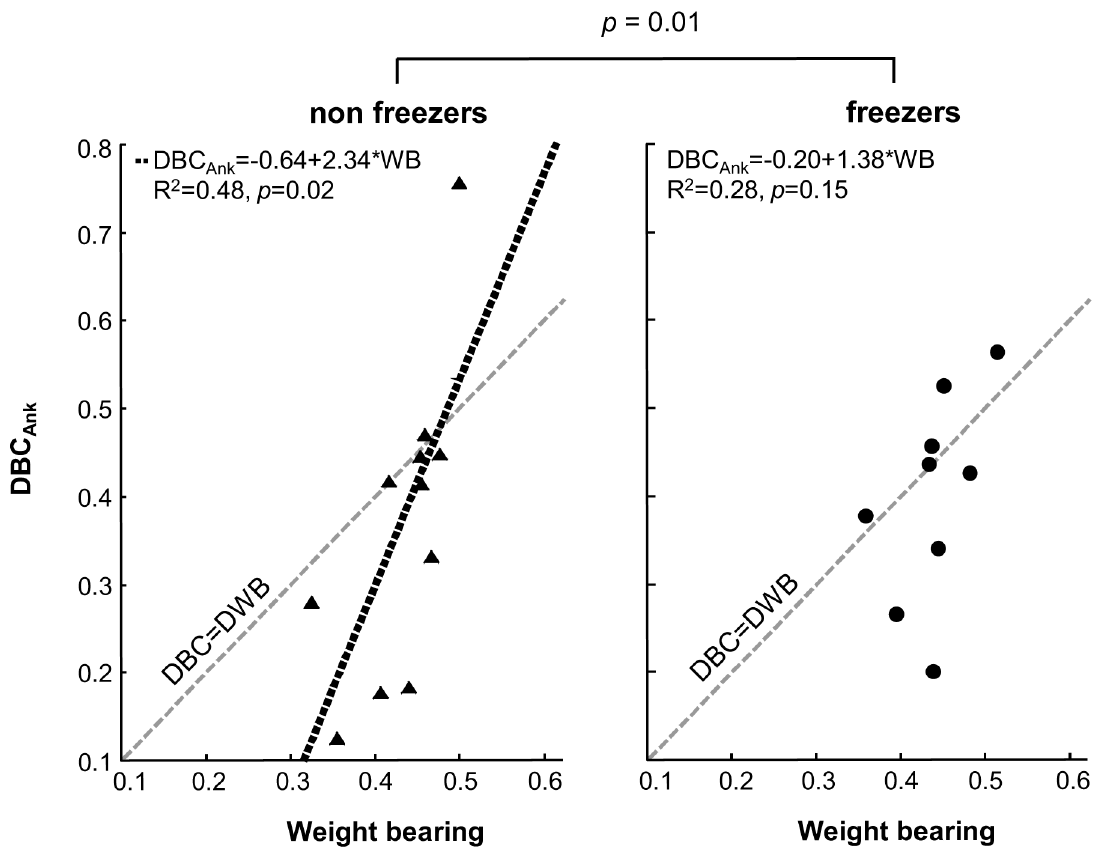
Figure 5. Dynamic-balance contribution of the ankle (DBC Ank ) vs. weight bearing of PD patients, shown separately for non-freezers (left panel) and freezers (right panel). The healthy one-to-one relationship (DBC=DBW) is indicated by the grey dashed line in both panels. The linear regression line between weight bearing and balance control for the non-freezers is indicated by dotted line. There was a significant difference between regression lines of freezers and non-freezers ( p =0.01). Freezers showed a non-significant relationship between weight bearing and balance control (R 2 =0.28, p =0.15), whereas non-freezers showed a significant relationship (R 2 =0.48, p =0.02). The * indicates a significant difference between the regression lines of the non-freezers and